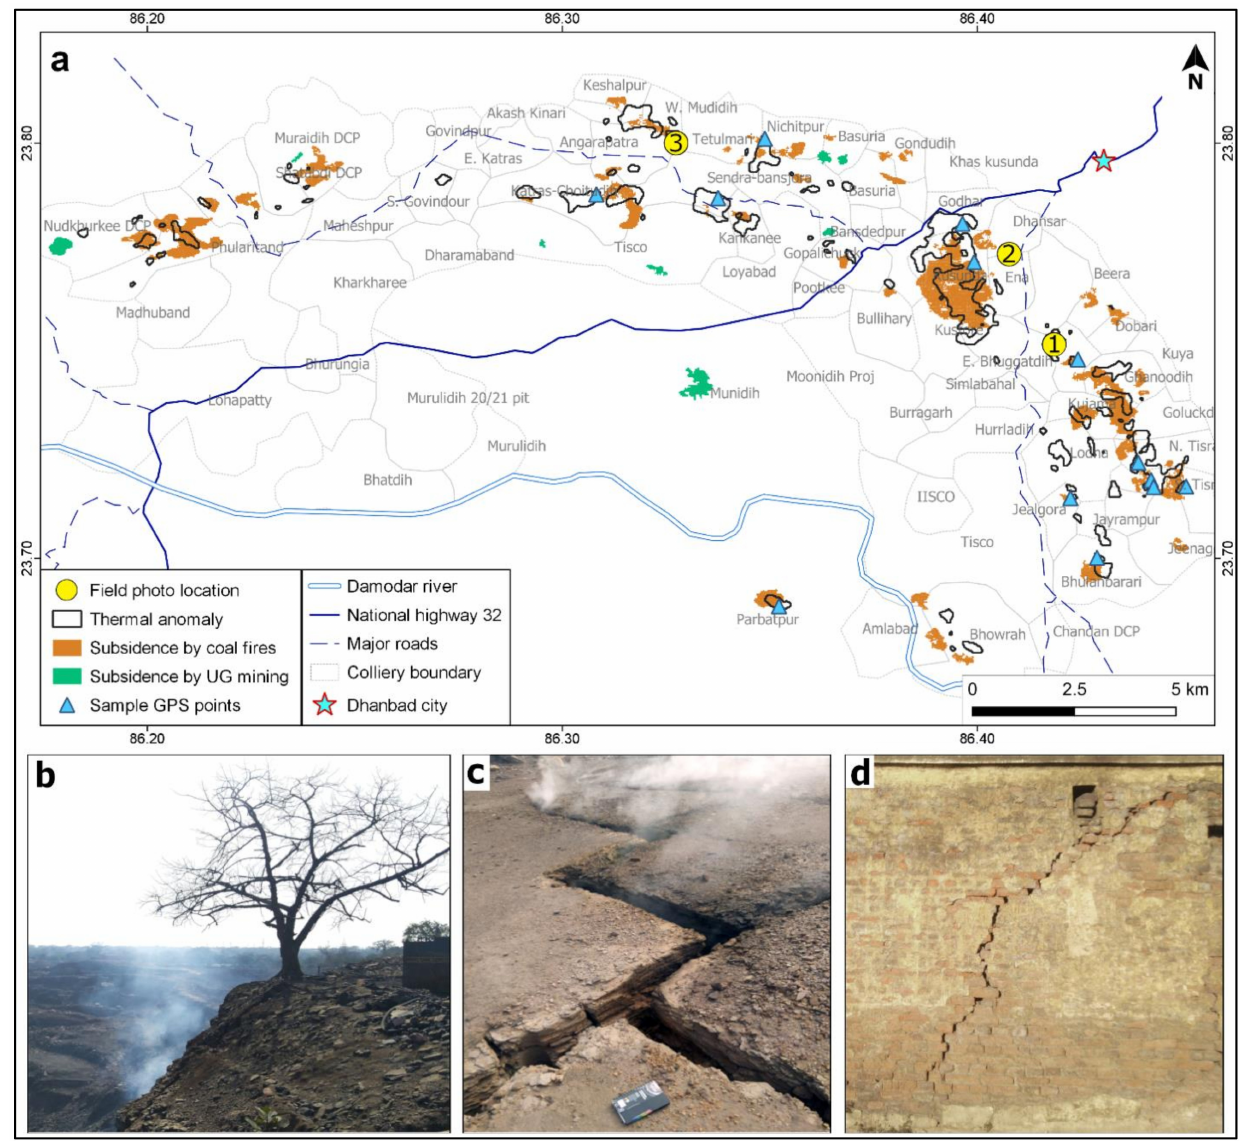
Figure 6. ( a ) Outlines of thermally anomalous regions overlaid on subsidence regions. Blue triangles represent GPS locations of coal fire sightings made in the field. ( b ) An opencast mine boundary. Smoke coming from sliced subsurface passages through which the hot gases from coal fires are transferred to the surface. ( c ) Surface crack induced by coal fires. Hot gases (by-products of coal fire) released through these cracks are also visible. ( d ) House wall cracked due to subsidence triggered by coal fires. Geo-location of the photographs shown in Figure 6b–d are shown in Figure 6a as 1,2,3